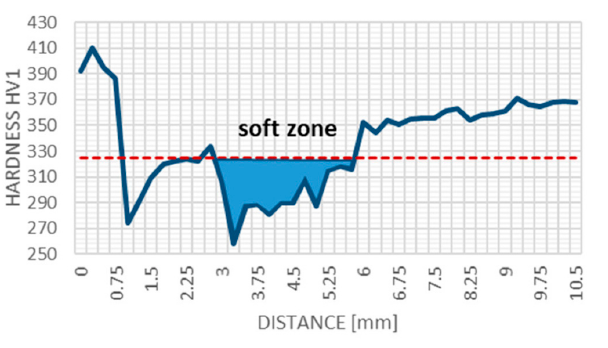
Figure 14. Calculation of soft zone width using microhardness measurements on GMAW-CMT weld. Hardness measurement performed by the Vickers method. Reprinted with permission from ref. [15]. Copyright 2021, MDPI.